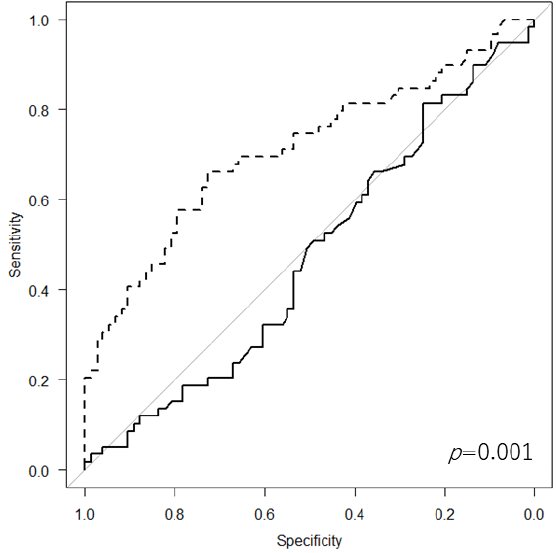
Figure 3. Receiver operating characteristic curve showing significant difference in area under the curve between absolute lymphocyte count (solid line) and lymphocyte-to-C-reactive protein ratio (dotted line).